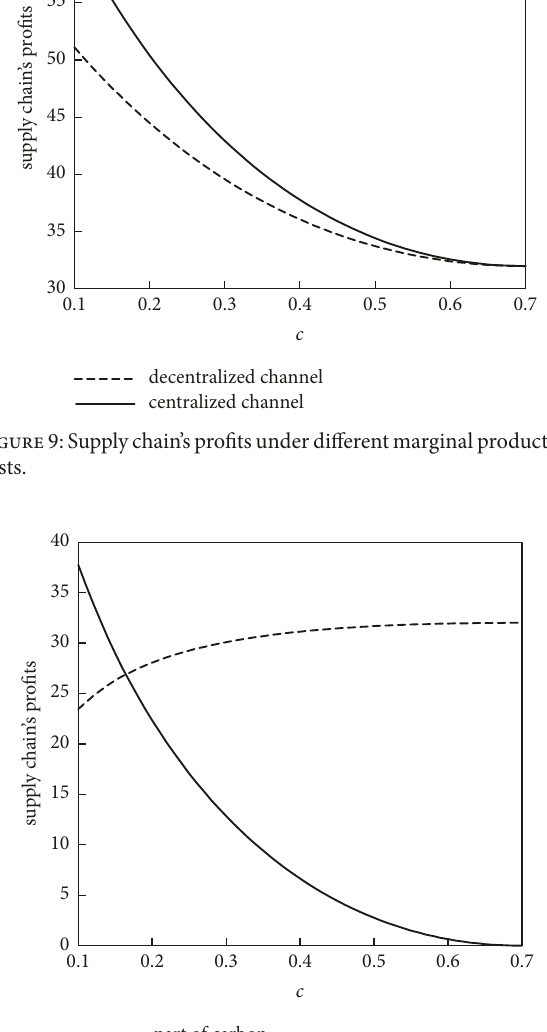
part of carbon part of product Figure 10: Profit structure under different marginal production costs in the centralized